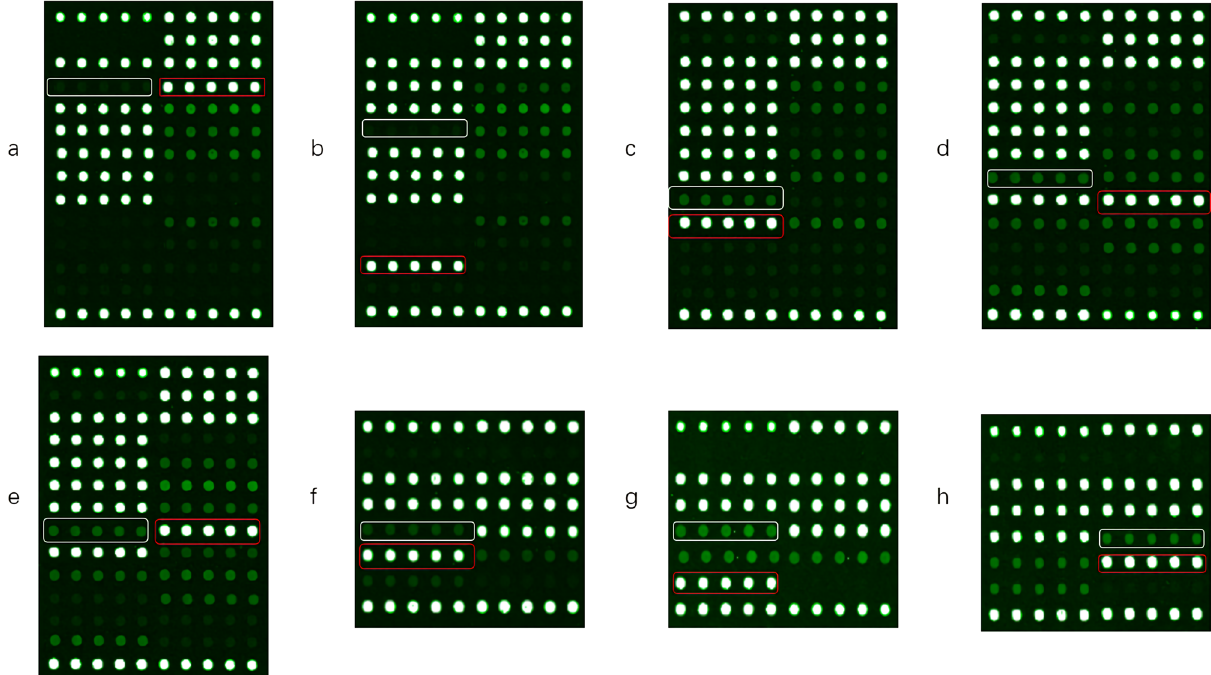
Figure 4. Pattern diagrams of several common drug-resistant gene mutations detected by the DNA microarray method. The white box is the detection site of the wild-type codon, and the red box is the site of the detected mutant codon. ( a ) rpoB gene Leu511Pro (CTG → CCG); ( b ) rpoB gene Asp516Tyr (GAC → TAC); ( c ) rpoB gene His526Tyr (CAC → TAC); ( d ) rpoB gene Ser531Trp (TCG → TGG); ( e ) rpoB gene Ser531Leu (TCG → TTG); ( f ) katG gene Ser315Thr (AGC → ACC); ( g ) katG gene Ser315Asn (AGC → AAC); ( h ) inhA gene promoter-15 (C →